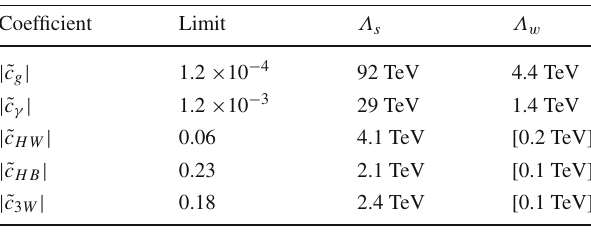
Table 2 LHC Run I constraints on the Wilson coefficients associated with the CPV EFT operators given in Eq. (2) (second column), also cast in the form of a bound on the effective scale for strongly coupled (third column) and weakly coupled (fourth column) new physics. The brackets indicate that the limit has been extracted under conditions not compatible with the expected EFT range of validity. We refer to Sect. 2 for details of how the limits on Λ w, s are defined